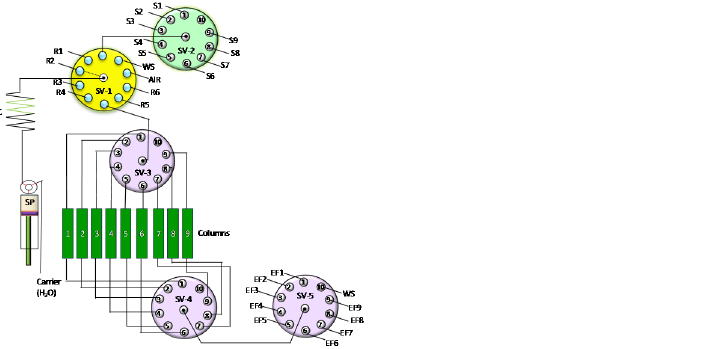
Figure 9. Schematic deposition of a flow system for four sample simultaneous processes [92]. SV: selection valve.